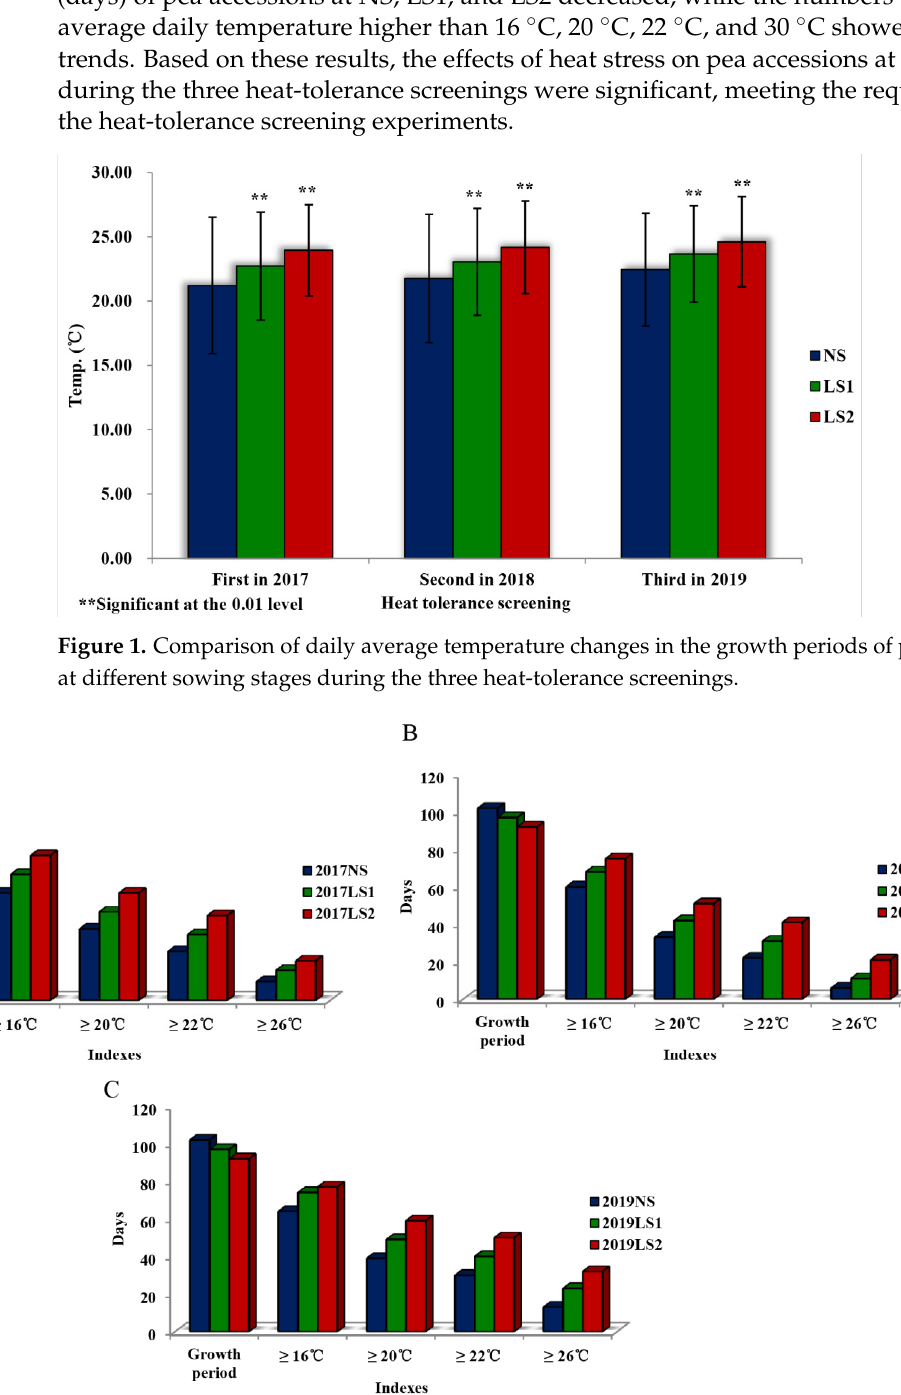
Figure 2. Comparison of the number of heat-stress days in the growth periods of pea accessions at different sowing stages during the three heat-tolerance screenings. ( A ) HST1 in 2017. ( B ) HST2 in 2018. ( C ) HST3 in 2019.